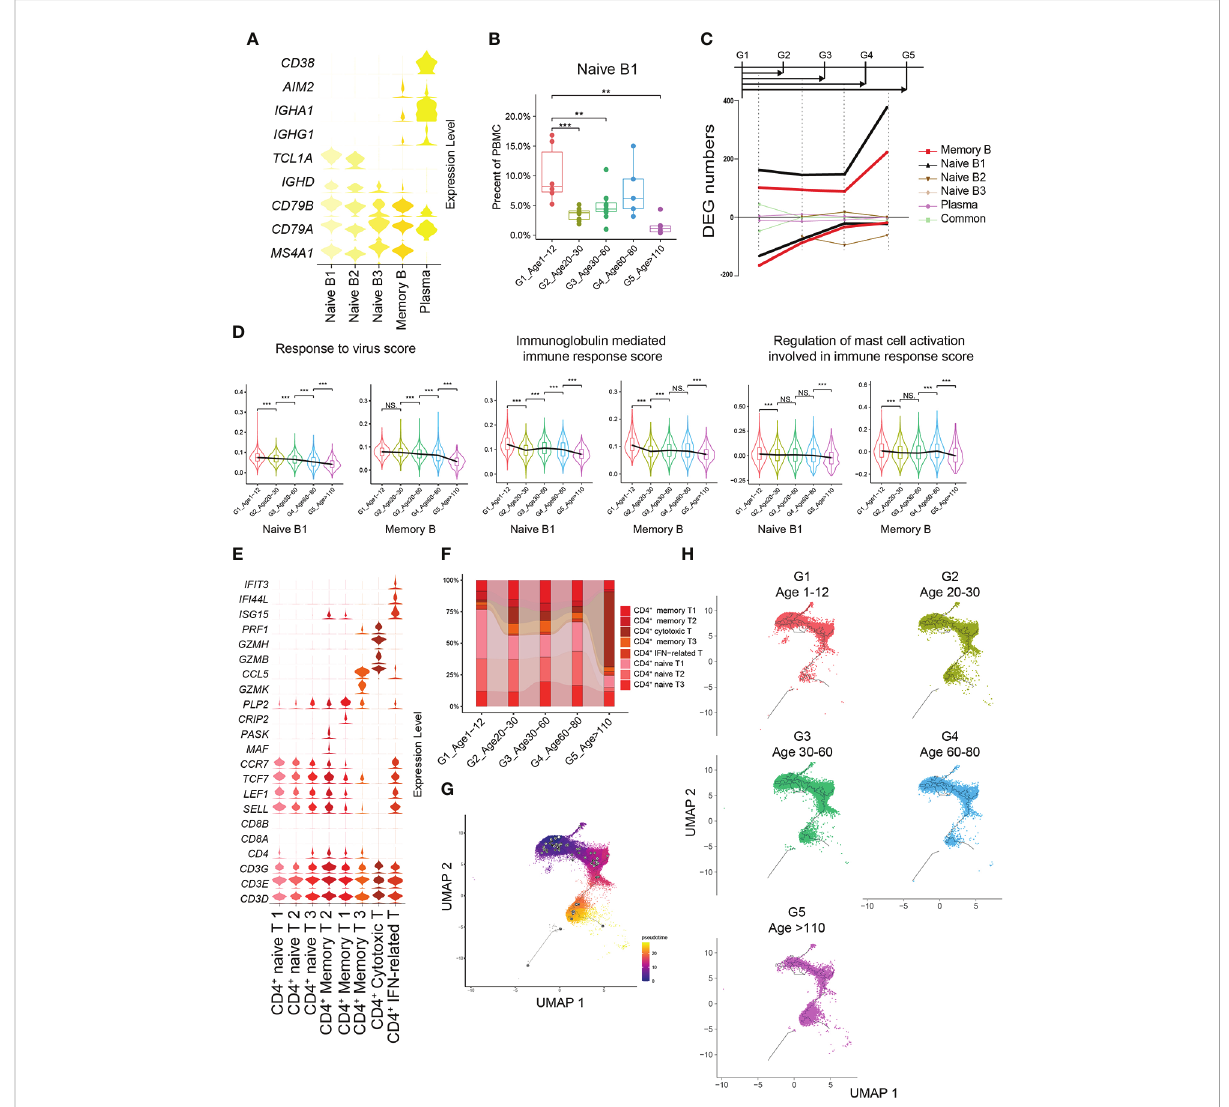
FIGURE 4 Molecular characterization of B cells and CD4 + T cells in multiple age groups. (A) Violin plots showing the expression distribution of selected canonical cell markers in the 5 subtypes of B cells. (B) Boxplots of the percentage of naive B1 subtype in PBMCs. All differences with P<0.01 are indicated. NS, not statistically signi fi cant; **P<0.001; ***P<0.0001. (C) Smoothed line plot displaying the number of speci fi c and common DEGs of different B cell subtypes for pairwise comparisons with a G1 reference. Positive (negative) values represent upregulated (downregulated) genes. (D) Expression levels of 3 GO biological process terms in naive B1 and memory B subtypes across the 5 age groups. All differences with P <0.01 are indicated. ** P <0.001; *** P <0.0001. (E) Violin plots showing the expression distribution of selected canonical cell markers in the 8 subtypes of CD4 + T cells. (F) Composition of CD4 + T cells in the 5 age groups. (G) Pseudotime trajectory of CD4 + T cells estimated using Monocle 3. (H) Pseudotime trajectory of CD4 + T cells in each group estimated using Monocle